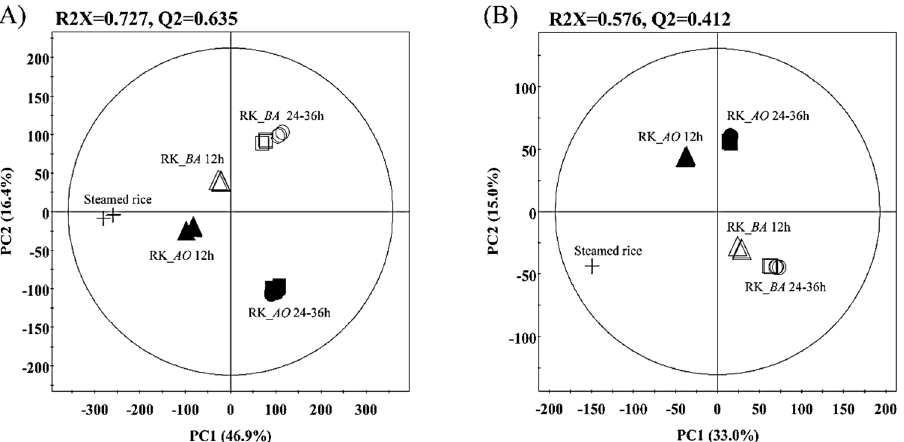
Figure 1. Principal component analysis (PCA) score plot for rice koji fermented with A. oryzae (RK_ AO ) or B. amyloliquefaciens (RK_ BA ) obtained by GC-TOF-MS ( A ) and UHPLC-LTQ-IT-MS/MS ( B ). (+, Steamed rice; unfilled symbols, RK_ AO ; filled symbols, RK_ BA ; △ , ▲ , 12 h; □ , ■ , 24 h; ○ , ● , 36 h).